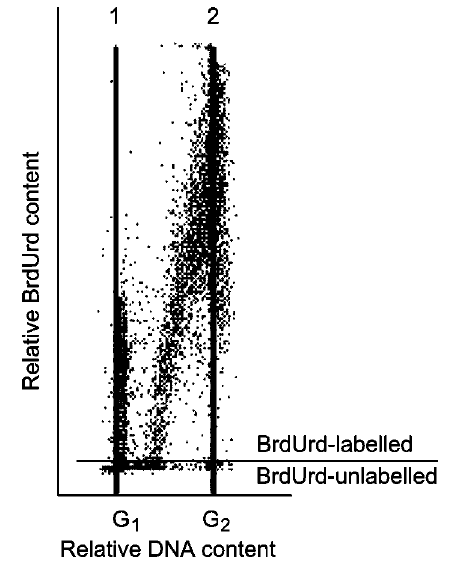
Fig. 1. Cytogram with mid-G 1 (Region 1) and mid-G 2 (Region 2) phase windows, which were set after determination of the mean DNA contents of G 1 and G 2 phase cells in the corresponding DNA histogram of the total cell population. CHO cells were labelled with 5 (cid:22) M BrdUrd for 30 min and then allowed to progress through the cell cycle for 4 hours before fixation and processing to detect Br- dUrd and DNA contents with FCM. The BrdUrd-labelled cells in G 1 and G 2 phases are seen to the right of the windows in the respective phase. Note that the BrdUrd-labelled divided cells in G 1 phase, ap- pearing as a narrow and vertical cluster, does not lean to the right (i.e., show any increase in DNA content) with increasing BrdUrd content. This implies that no leakage of FITC into the PI detector